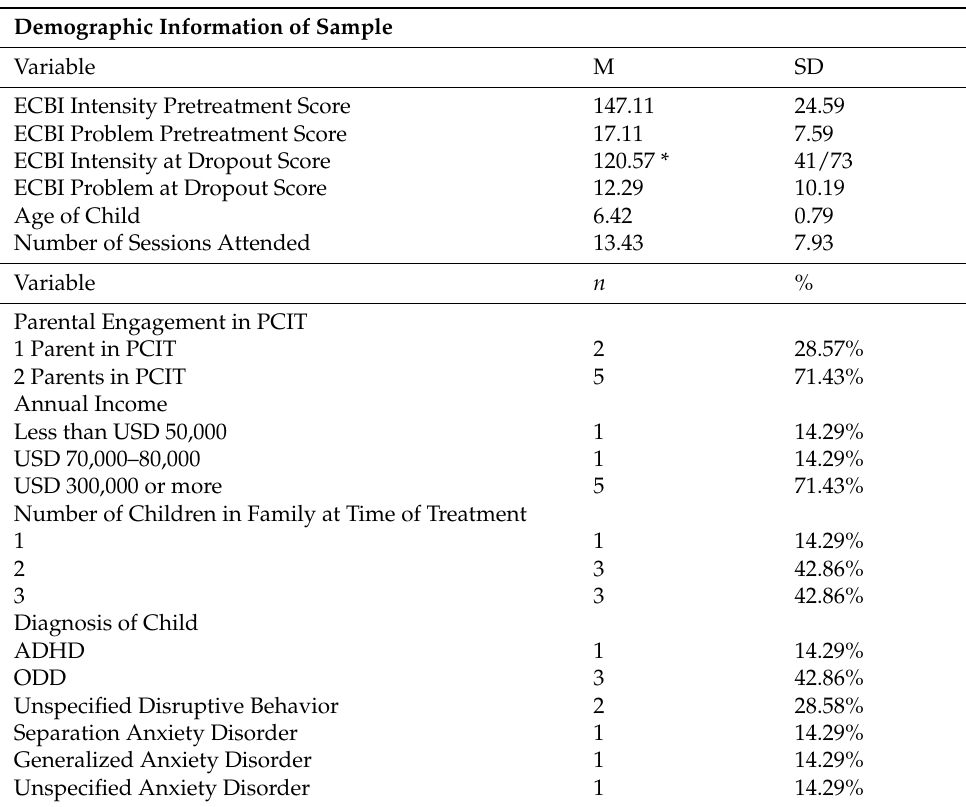
Table 1. Demographic Information of